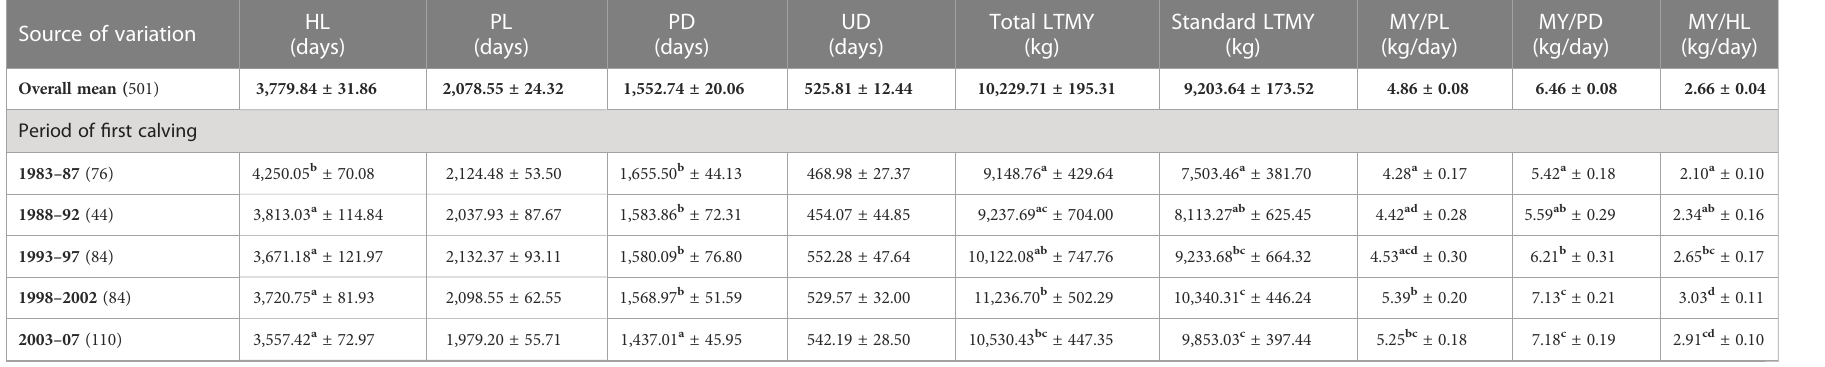
TABLE 2B Least-squares means LSMs with standard errors SEs for lifetime performance traits in Nili-Ravi buffaloes.